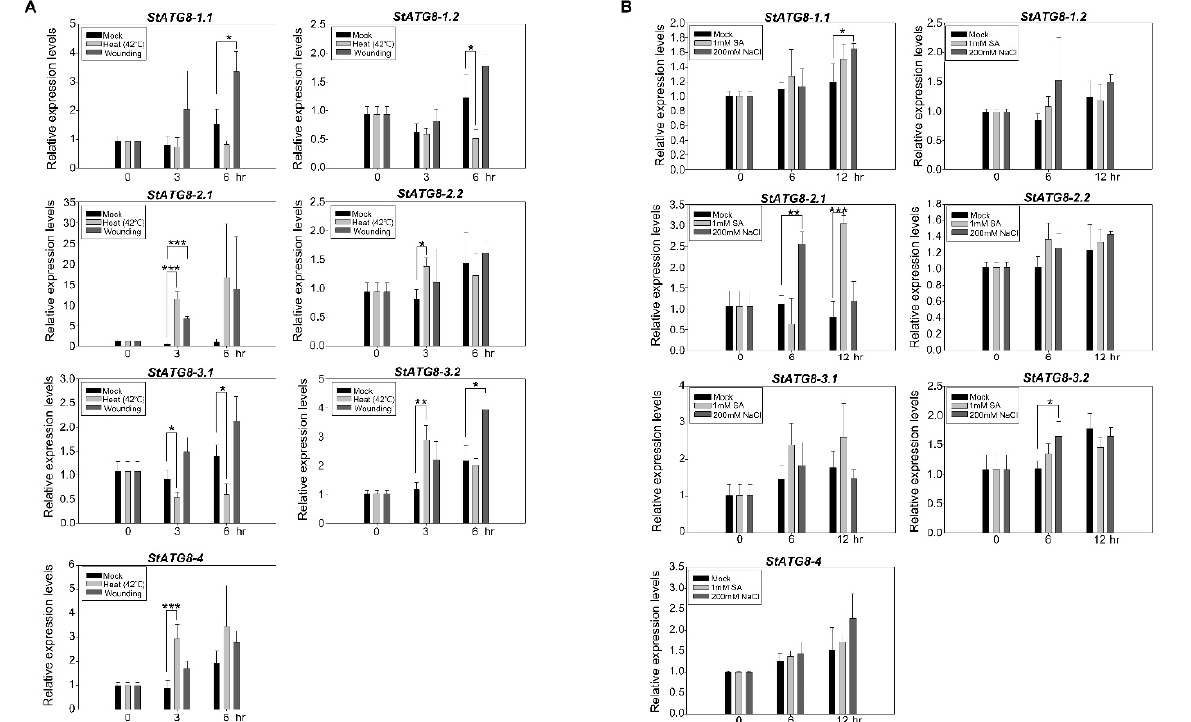
Figure 4. Expression analysis of StATG8s in response to multiple stresses. ( A , B ). Real-time PCR analysis of StATG8 genes in response to heat (42 °C), mechanical wounding ( A ), 1 mM salicylic acid (SA), and 200 mM NaCl treatments ( B ). For stress treatments, 4-week-old potato plants were used to stress treatment for the indicated times. StEF1 α was used as a reference gene. Error bars indicate the standard deviations of three independent qRT-PCR biological replicates. Asterisks indicate significant differences from the control using the unpaired Student’s t -test (* p < 0.05, ** p <0.01, and *** p < 0.001).